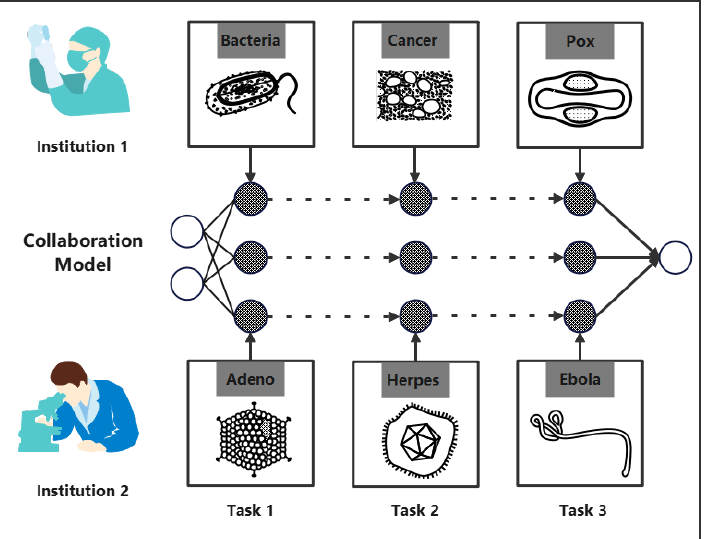
Figure 1. Joint modeling for different stages of disease research from different